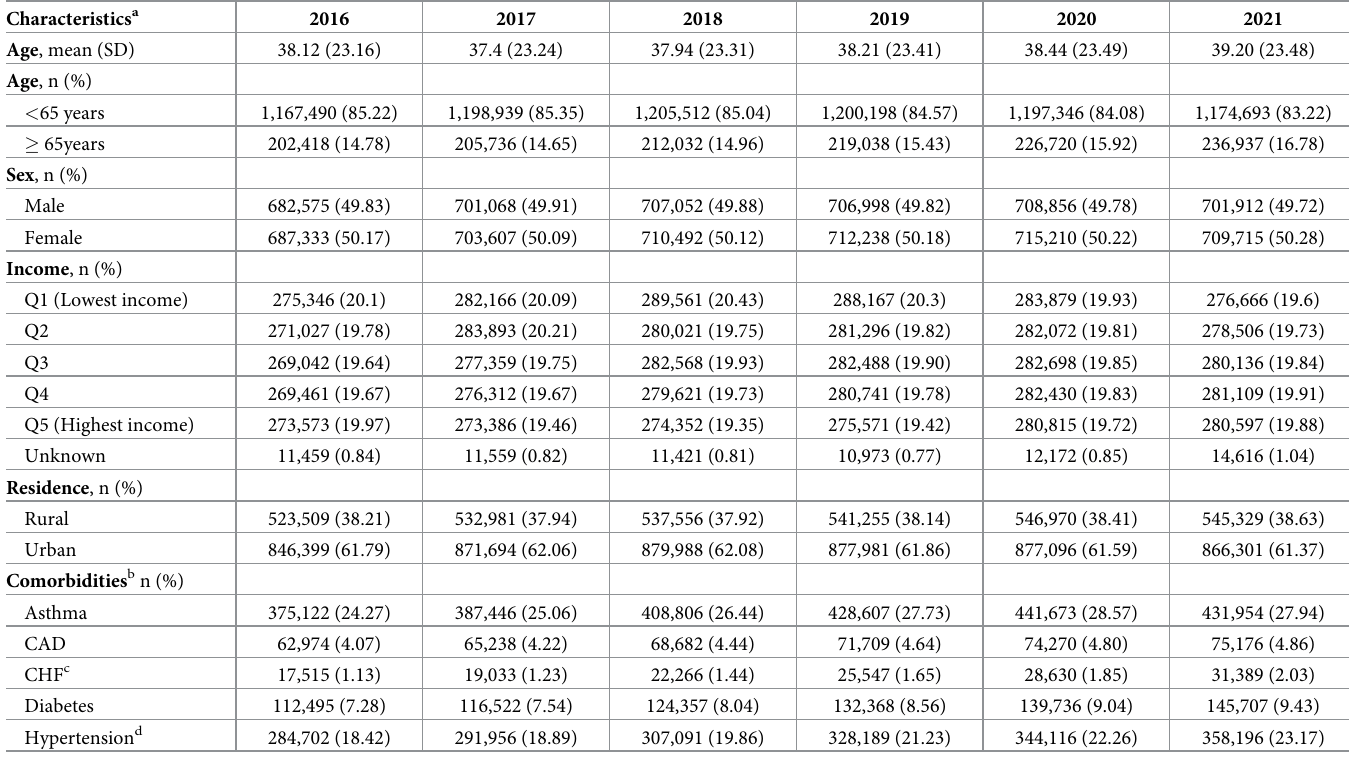
Table 1. Characteristics of the included Manitoba population from July 2016 to March